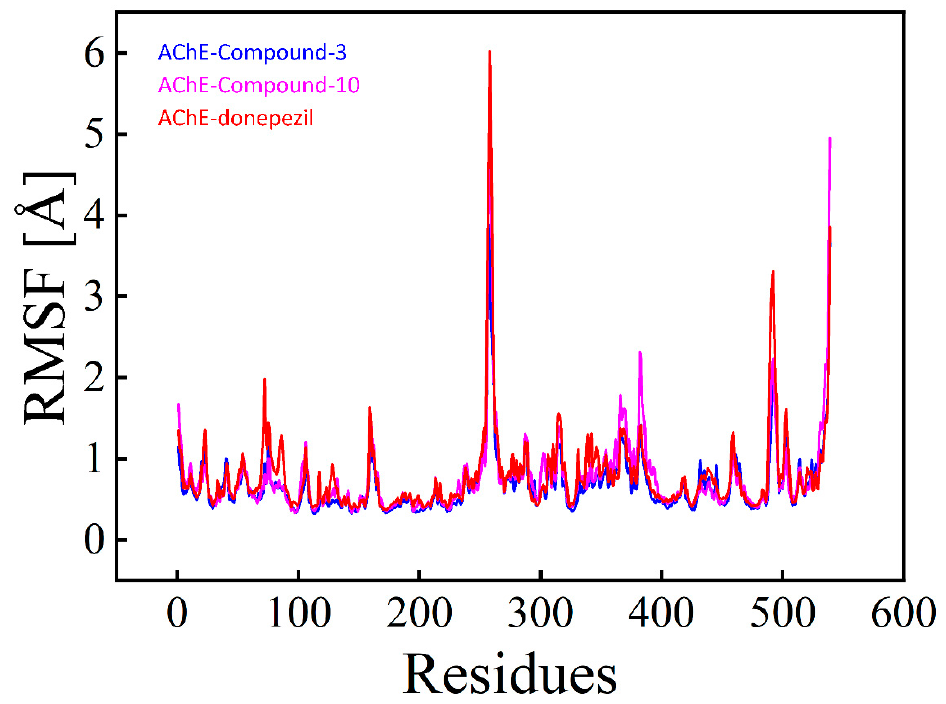
Figure 5. RMSF plot of compound 3 (blue color), compound 10 (magenta color), and donepezil (red color) in complex with AChE.